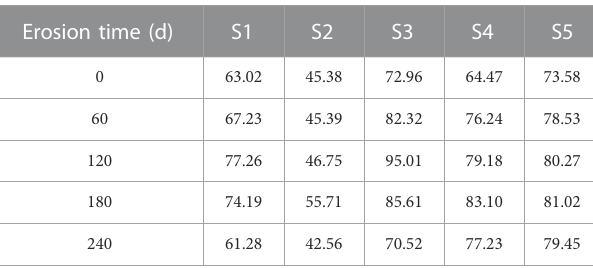
TABLE 3 Compressive strength of each specimen